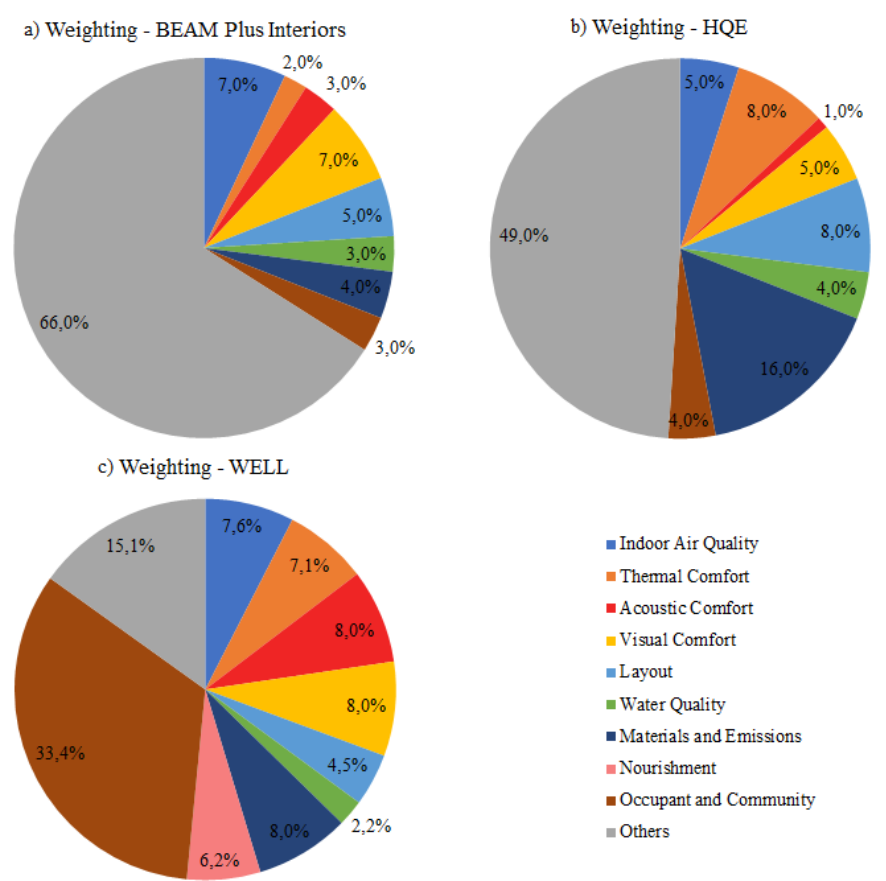
Figure 1. Weight by category of certifications: a) BEAM Plus Interiors, b) HQE and c) WELL.